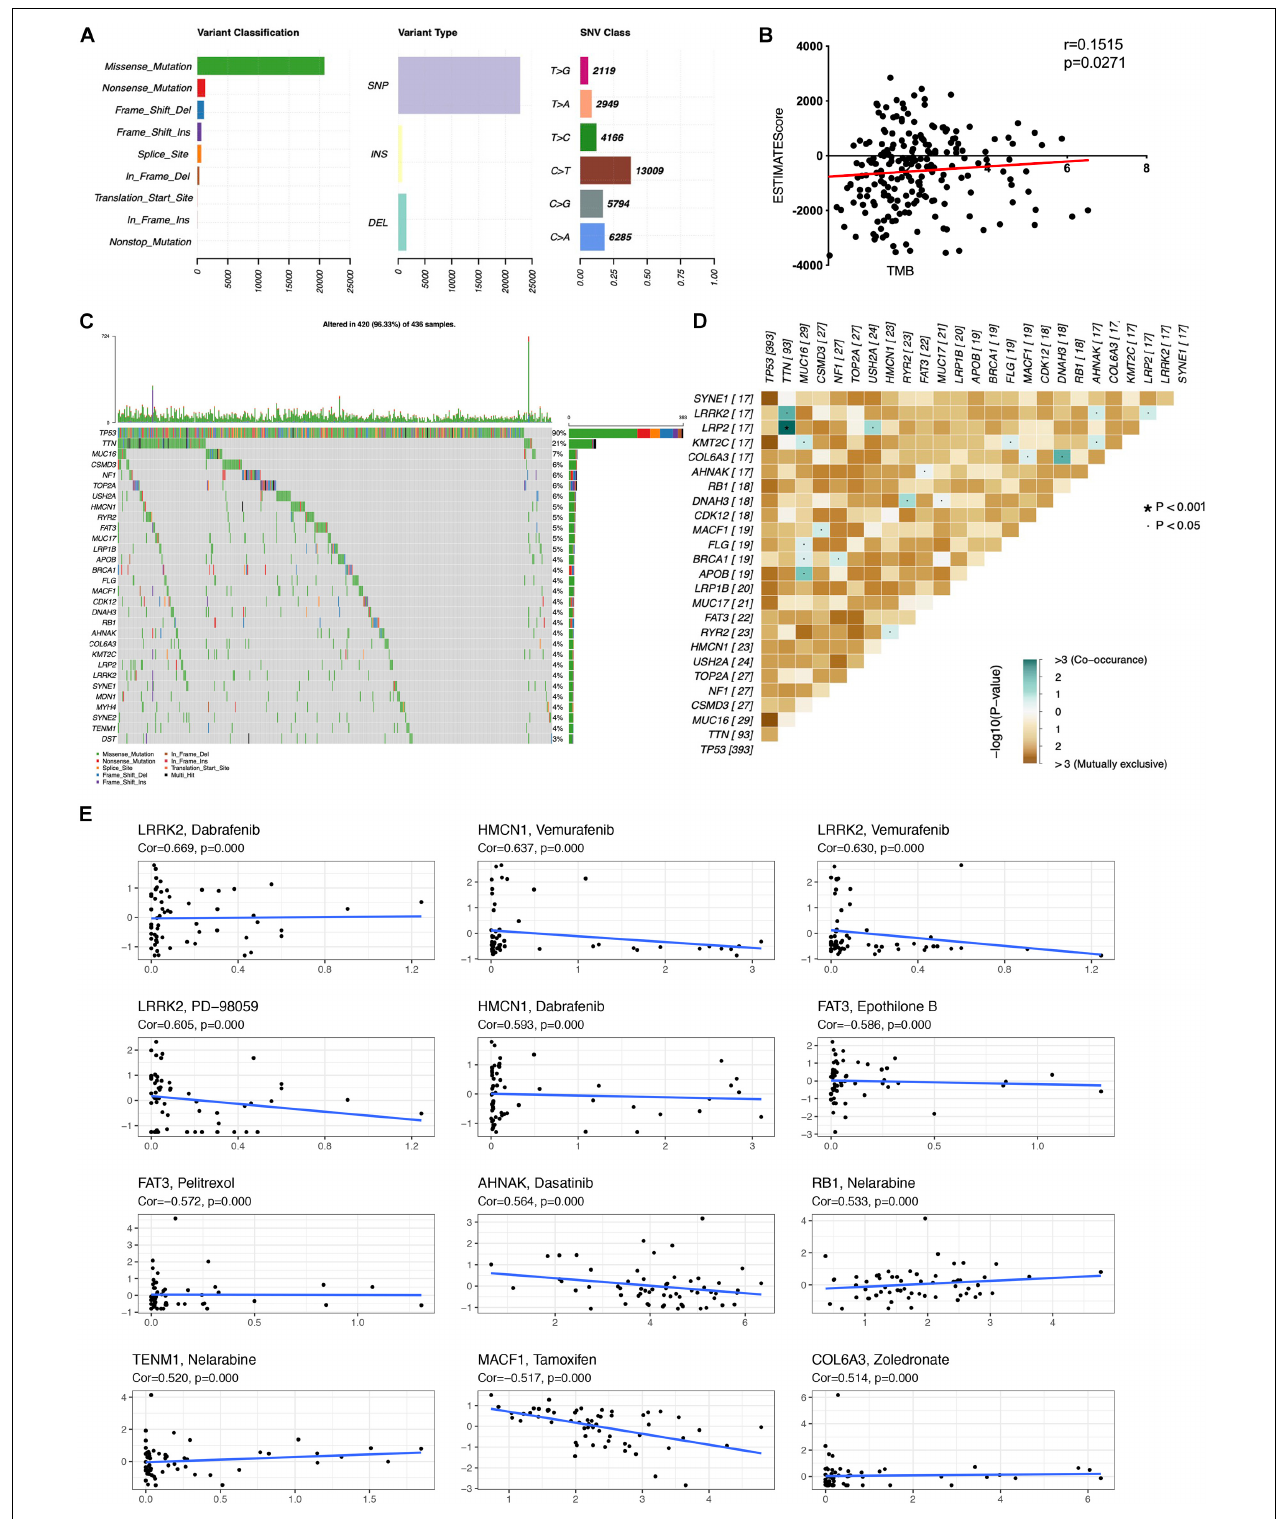
FIGURE 3 | Associations of mutation in immune subtype. (A) The overall summary of mutation information in the OC cohort. (B) The correlation of TMB with ESTIMATEscore in OC. (C) The waterfall plot shows the top 30 mutated genes in OC cohort and their mutation information. (D) The significant co-occurrence of gene mutations in OC. (E) The associations of top mutation gene expressions with drug sensibility. TMB, Tumor mutation burden. The statistical significance was defined as p < 0.05.